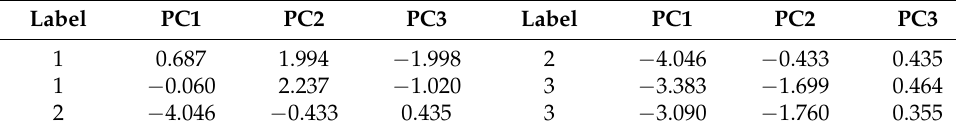
Table 4. The distribution of state parameters after KPCA in each fault state.